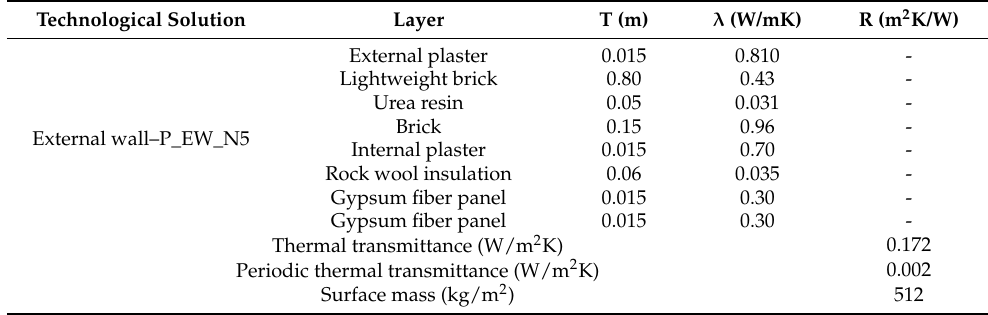
Table A11. Possible upgrade measure of external wall stratigraphy (P_EW_N5) with the insufflation of urea resin to fill the air gap.